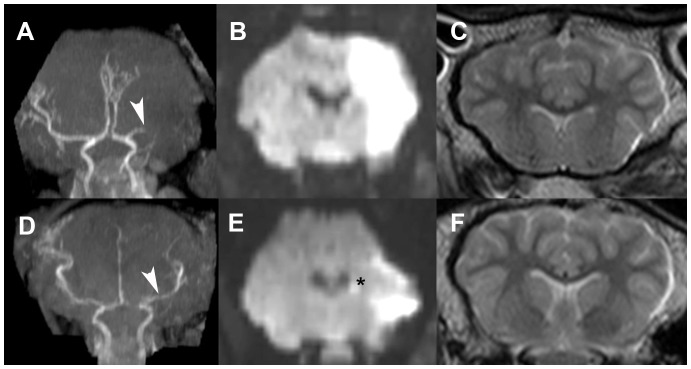
MRI at 4 hours after MCAO, coronal orientation.Permanent MCAO MRA (A), DWI (B) and T2 weighted imaging (C). Temporary MCAO with reperfusion MRA (D), DWI (E) and T2 weighted imaging (F). Arrowhead on MRA indicates site of arterial occlusion. Asterisk indicates restricted diffusion at caudate head after temporary MCAO. DWI, diffusion weighted imaging; MCAO, middle cerebral artery occlusion; MRA, magnetic resonance angiogram; MRI, magnetic resonance imaging.